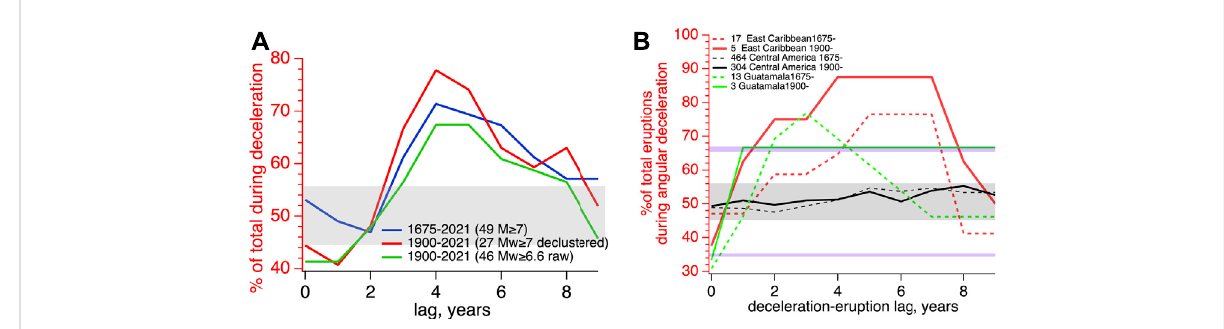
FIGURE 5 (A) . Percentage earthquakes for the Caribbean plate boundary (for indicated time intervals and subsets of data) occurring following the angular deceleration time series (Figure 1B) with lags 0 – 9 years: 78% of Mw ≥ 7 earthquakes since 1900, and 70% since 1675 occur after a 4-year lag. (B) . Percentages of volcanic eruptions in the Eastern Caribbean and Guatemala following the deceleration time series for various lags. Central American volcanoes areevidentlyindifferenttodeceleration.Thegreyareasineach fi guremask thepercentages anticipated forrandomoccurrence;the violet lines indicate random occurrence limits for ≈ 10